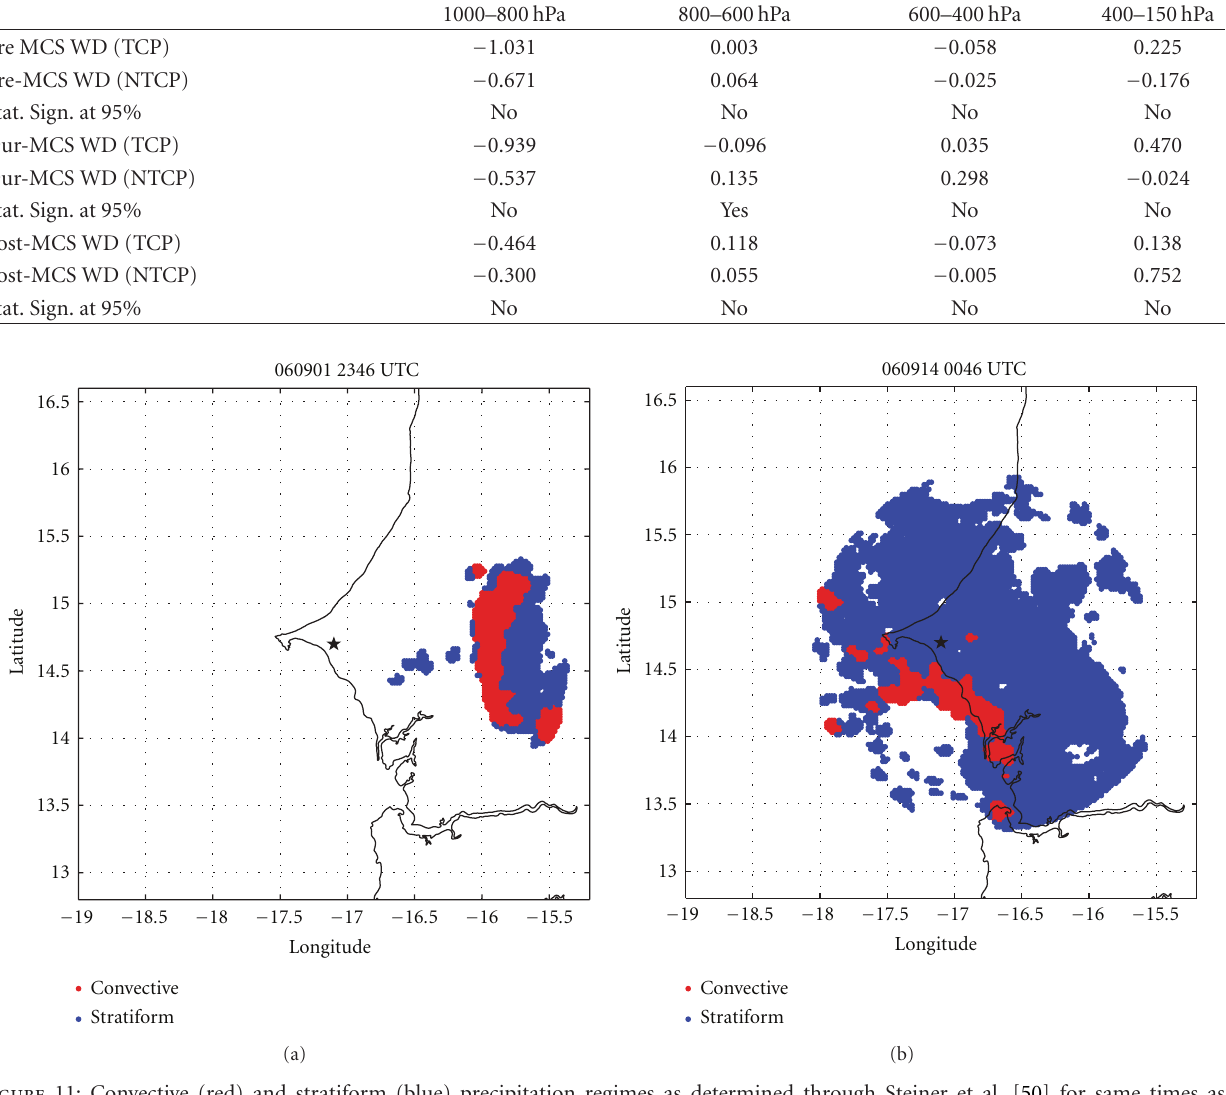
Figure 11: Convective (red) and stratiform (blue) precipitation regimes as determined through Steiner et al. [50] for same times as Figure